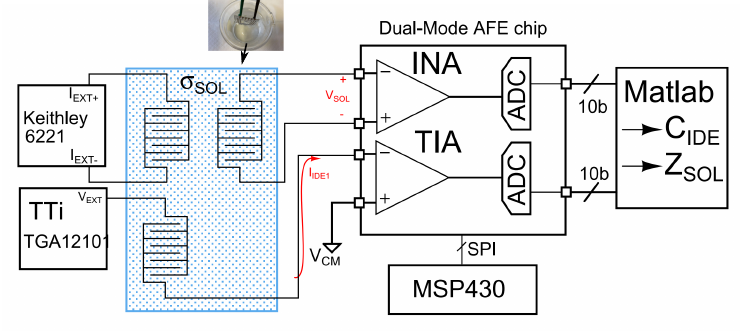
Figure 18. Experimental set-up. Two sets of IDEs were used in the experiments to measure the interface impedance and the solution conductivity, which was changed by varying the concentration of